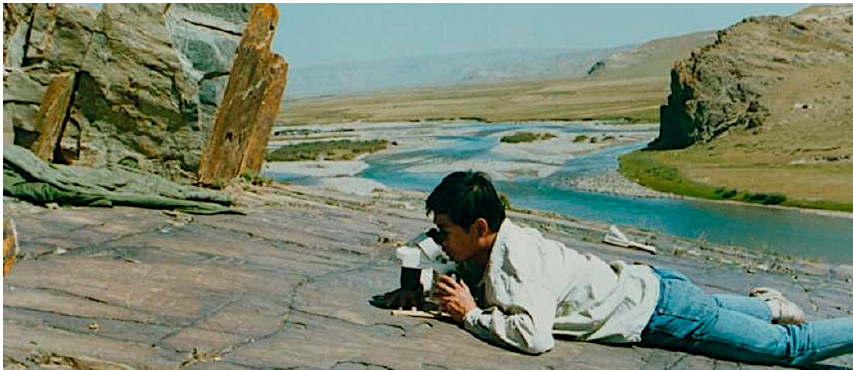
Figure 1. Tang Huisheng conducting the first replicable direct dating of rock art in China in 1997 at the Lushan petroglyph site in Qinghai Province (photograph by Gao Zhiwei, with permission).